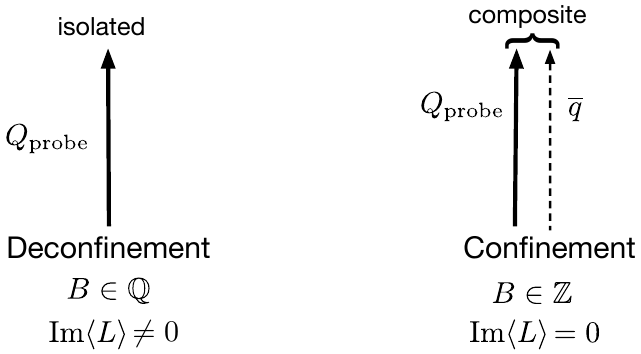
Figure 1 . How to de(cid:12)ne con(cid:12)nement. Here Q probe is the probe quark representing the Polyakov loop, and q is a dynamical anti-quark. In the con(cid:12)nement phase (Right) the baryon number B R , while in the decon(cid:12)nement phase (Left) it is not is always integer and hence e i(cid:25)B = 1 (cid:6) 2 necessarily integer because quarks have fractional baryon number 1 =N c and hence e i(cid:25)B